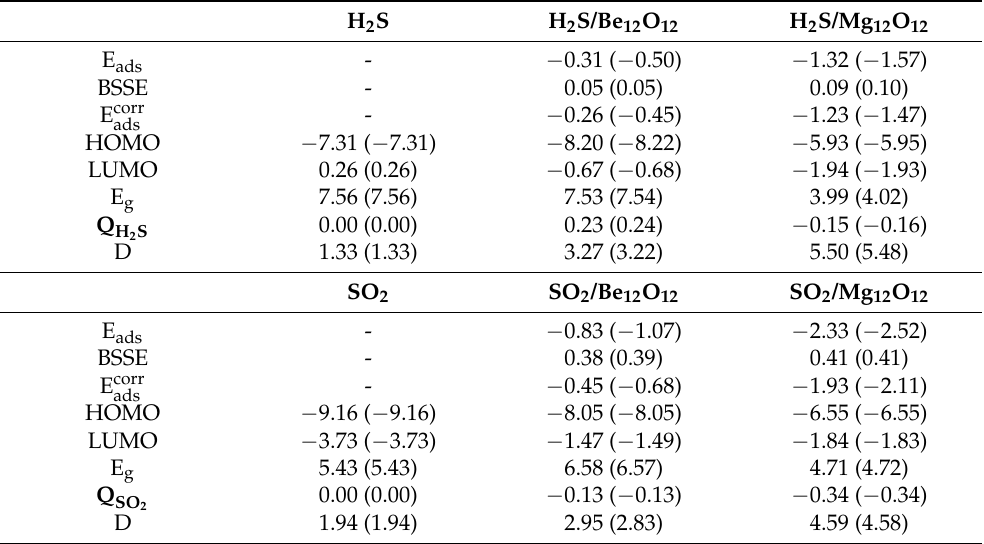
Table 2. Adsorption properties of H 2 S as well SO 2 on Be 12 O 12 and Mg 12 O 12 nano-cages. Adsorption energies (E ads , eV), Basis set superposition error (BSSE, eV), corrected adsorption energy (E corr HOMO and LUMO energy levels (eV), HOMO- LUMO gap (E g , eV), NBO charges (Q, e), and dipole moment (D, Debye). H 2 S H 2 S/Be 12 O